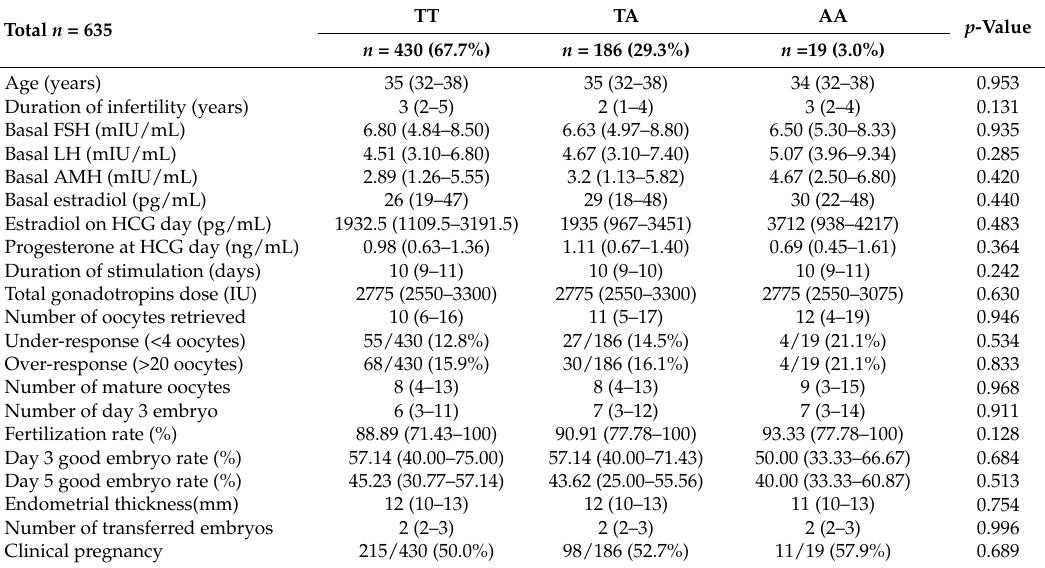
Table 3. Baseline characteristics and IVF treatment cycle outcomes of patients with different AMHRII IVS1 +149 T > A (rs2272002) SNP.